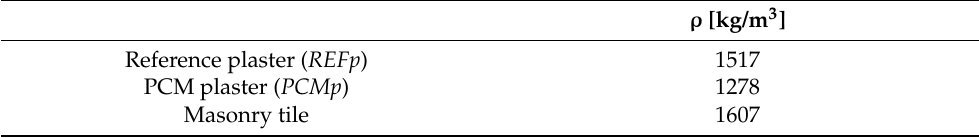
Table 2. Estimated densities of the material.